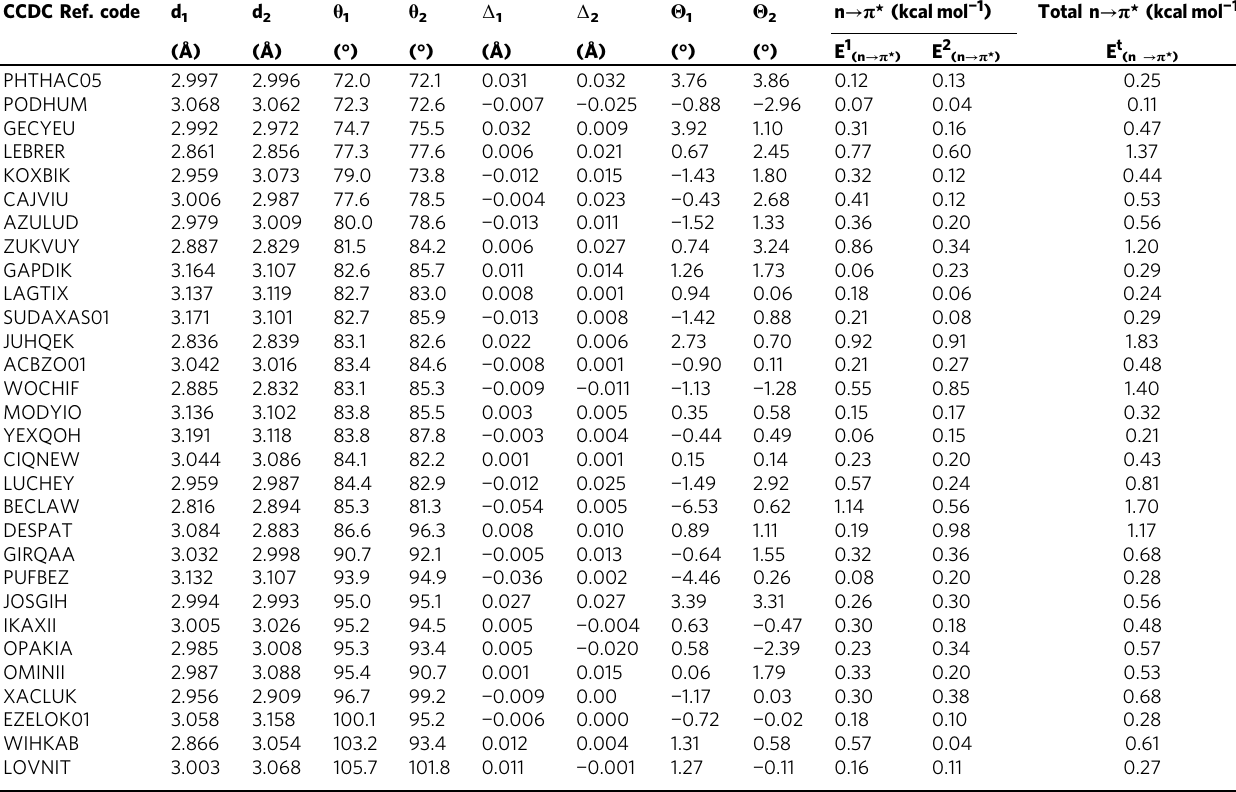
Table 2 X-ray crystallographic structural and NBO data of CSD molecules CCDC Ref.